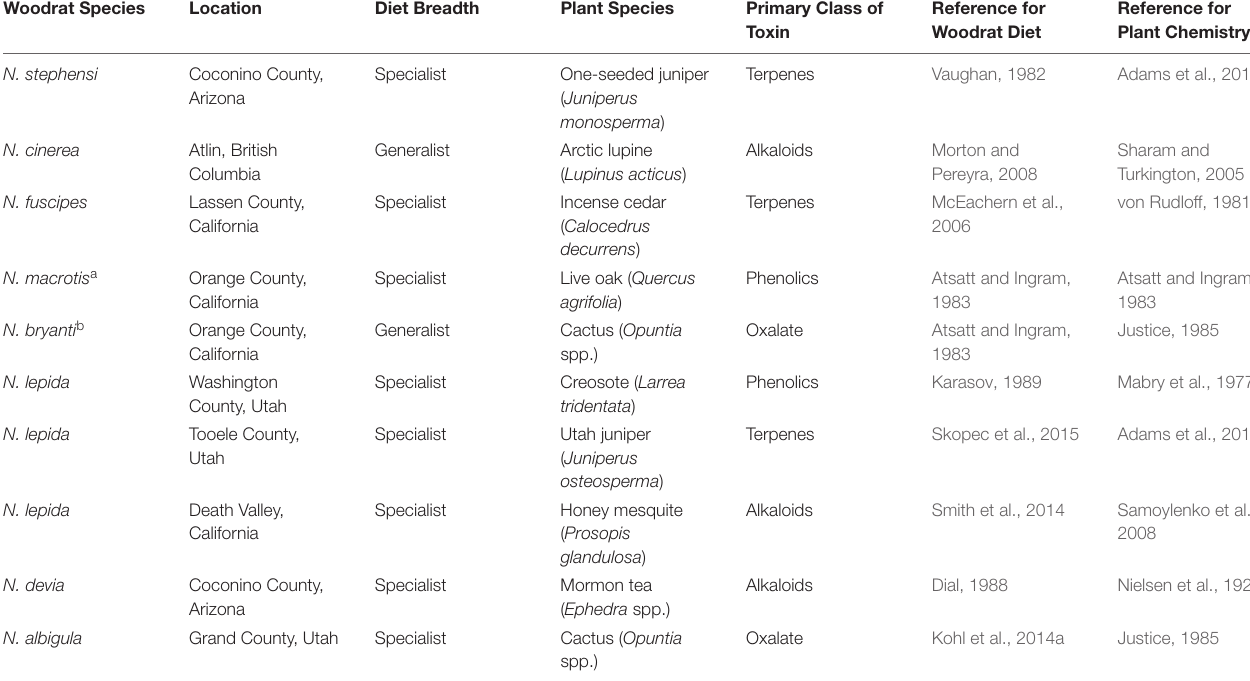
TABLE 1 | Details of dietary specialization in various woodrat species.